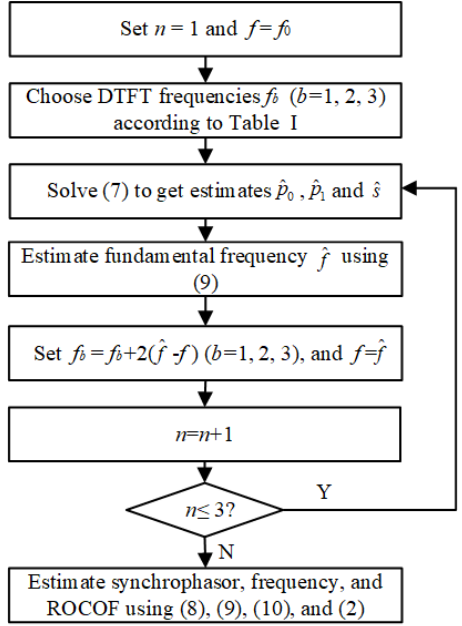
Figure 3. Implementation steps of the e-IpD 2 FT.